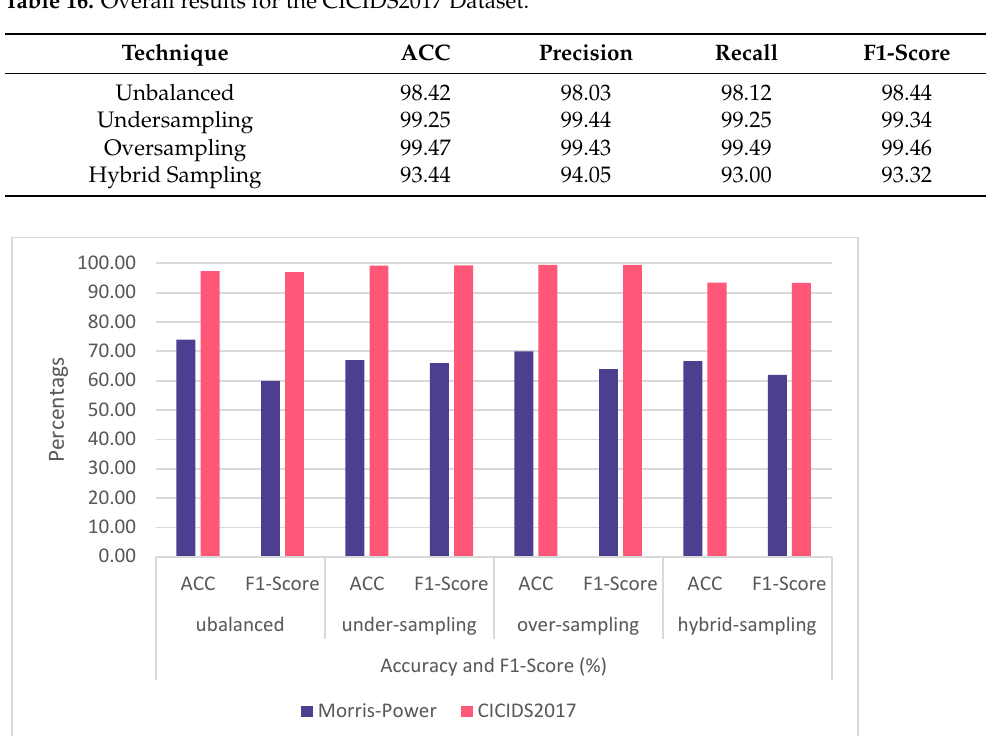
Figure 6. The F1 ‐ score and accuracy of both datasets in all four experiments. Figure 6. The F1-score and accuracy of both datasets in all four Table 15. Overall results for the Morris power dataset.